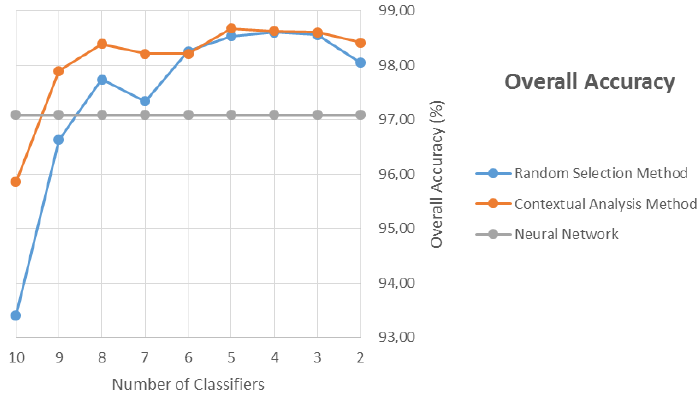
Figure 5. Evolution of the kappa coefficient for the results of the classifier ensembles.